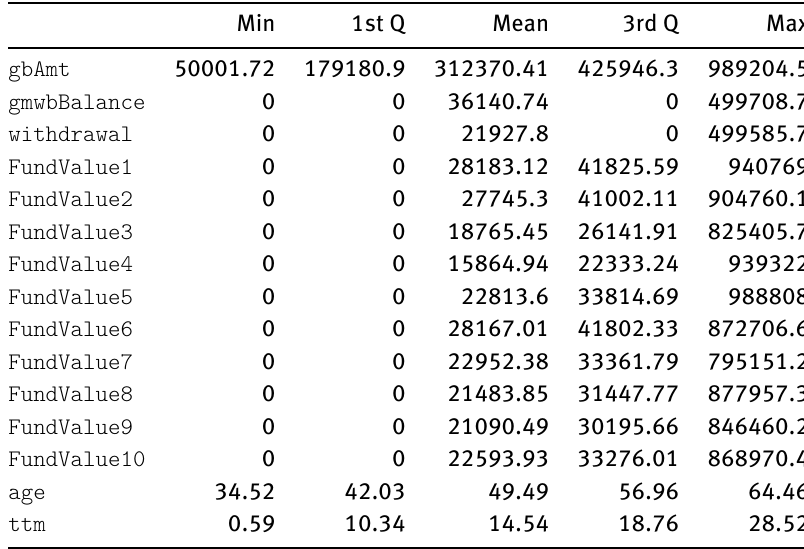
Table 7: Summary statistics of some fields. Note that age and ttm are calculated from the birth date, valuation date, and matu- rity date.